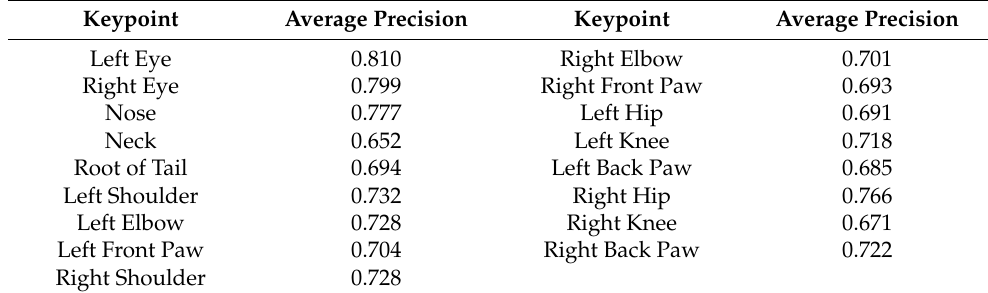
Table 2. Average precision of keypoints.